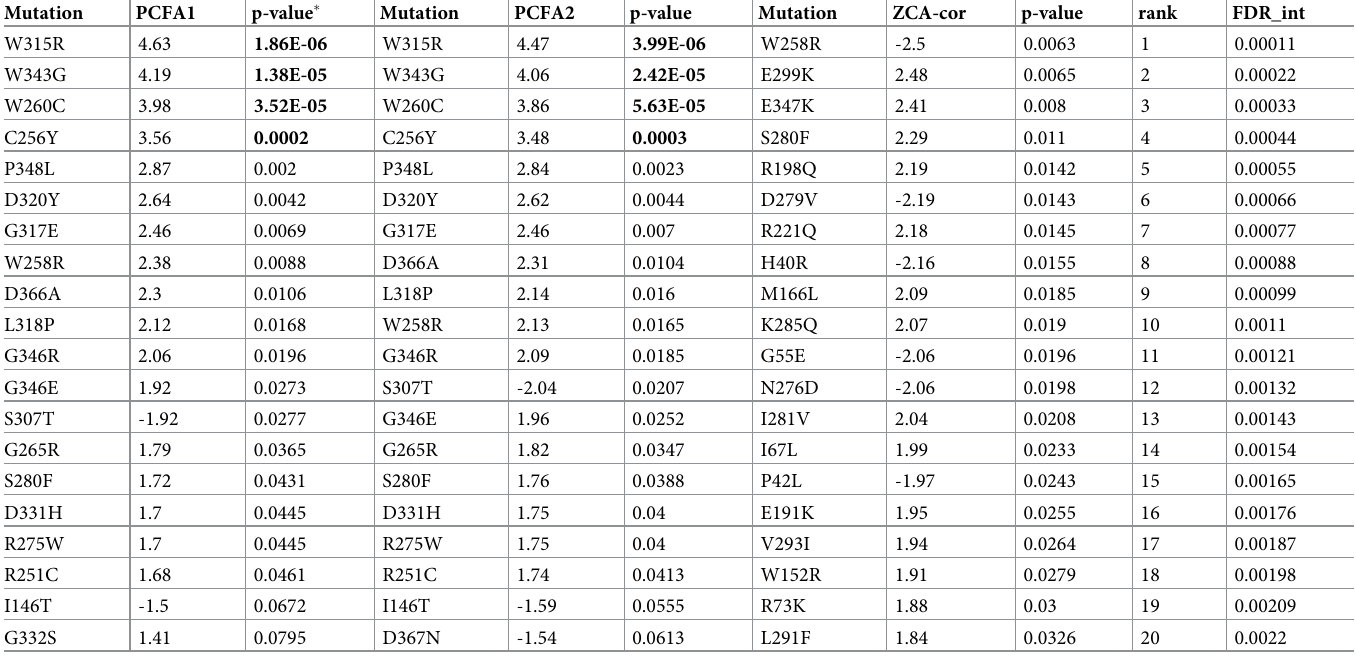
Table 3. Results for PCFA1, PCFA2, and ZCA-cor composite